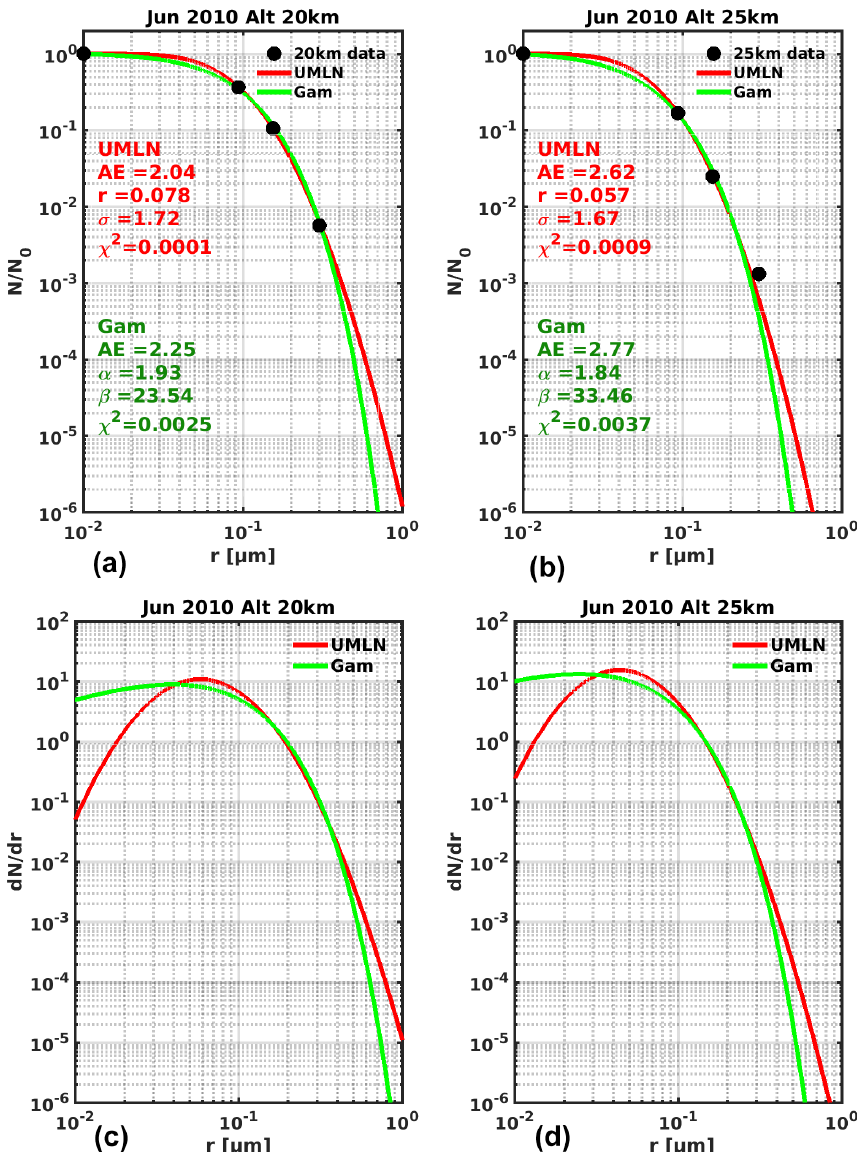
Figure 1. Topmost figures show examples of fitting the cumulative form of the UMLN (red line) and the gamma (green line) distributions to the June 2010 OPC data at altitudes 20km (a, c) and 25km (b, d) using the minimum χ 2 technique. The figures also show the results of each fit, the minimized χ 2 , and the Ångström exponent derived from the fitted parameters. The figures at the bottom show the differential form of the two